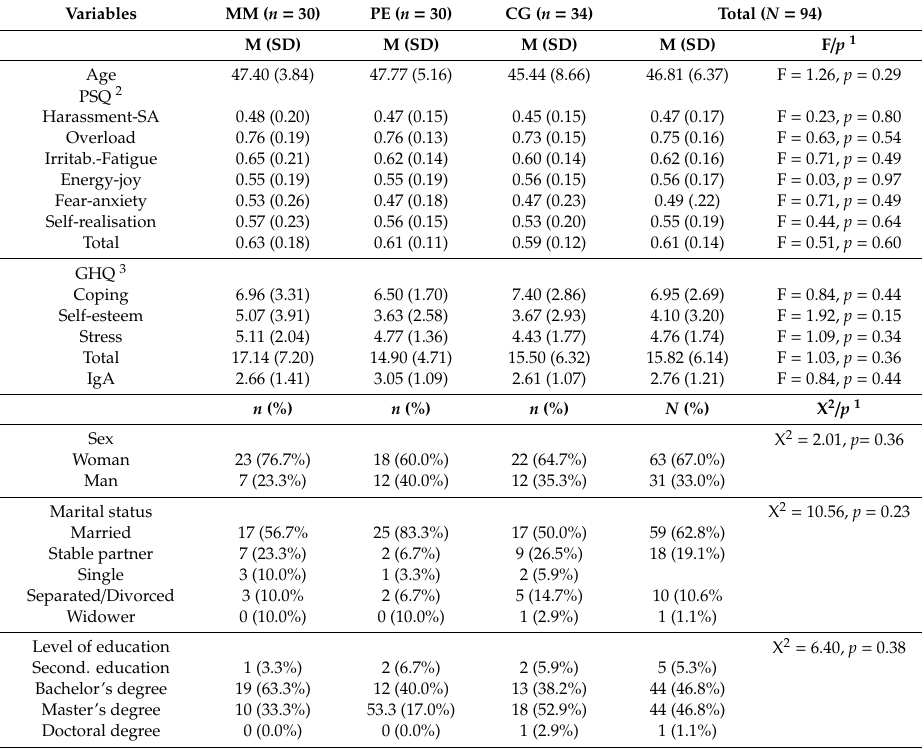
Table 1. Descriptive analysis and comparisons of sociodemographic and dependent variables on the